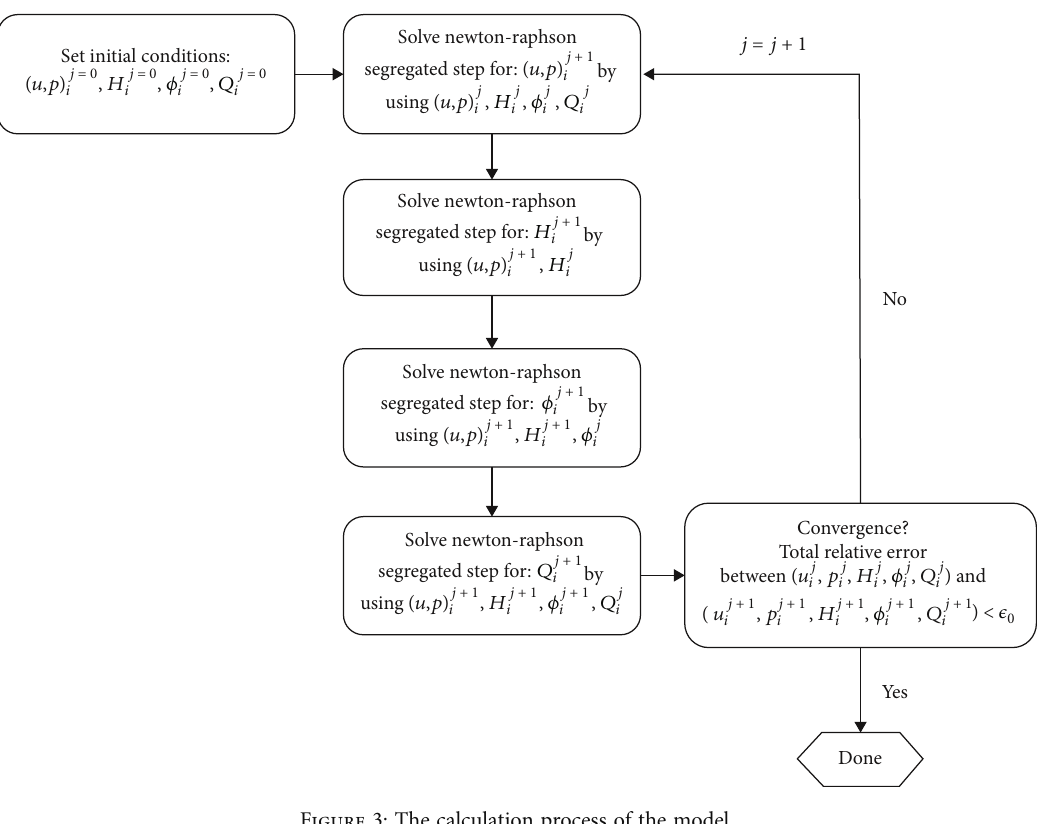
Figure 3: The calculation process of the